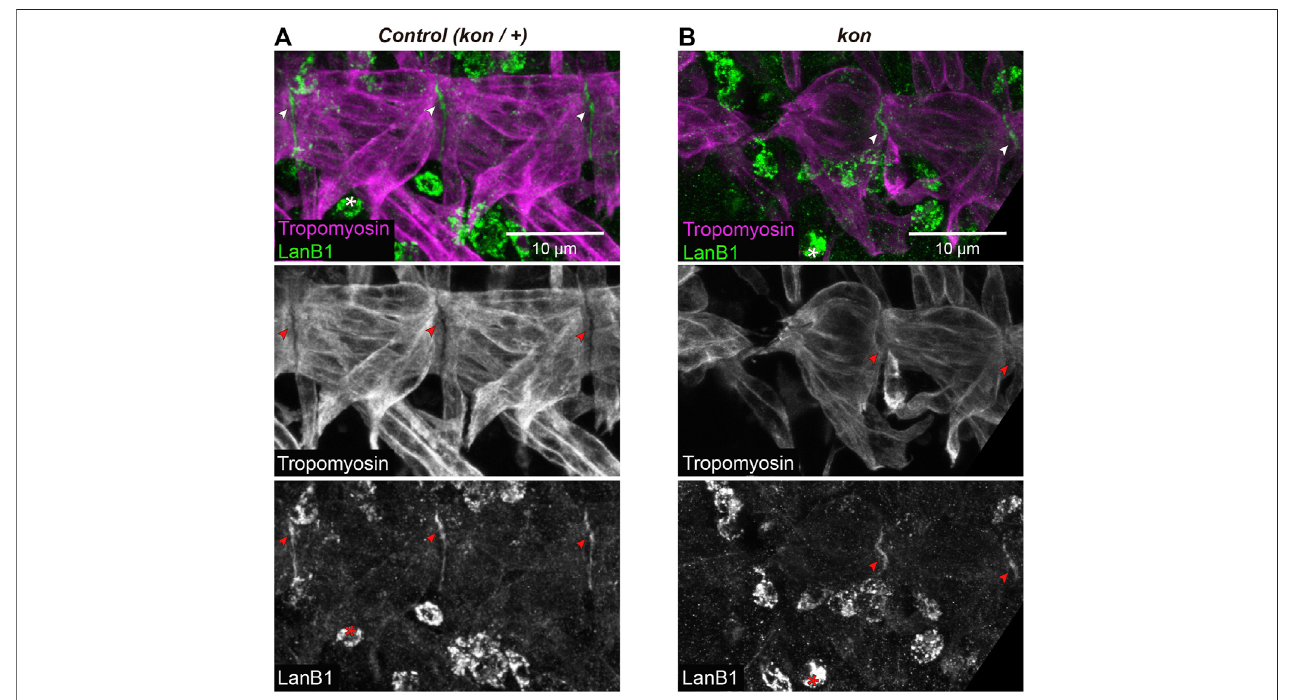
FIGURE 4 | LanB1 distribution at the MTJ. (A,B) Representative examples of confocal projections of st. 16 embryos, where the VL muscles of two hemisegments are shown. Muscles are labeled with anti-Tropomyosin; arrowheads indicate MTJ regions (intersegmental regions) showing LanB1 enrichment; asterisks indicate haemocytes. See Supplementary Figure S2 for a detailed view of the corresponding confocal